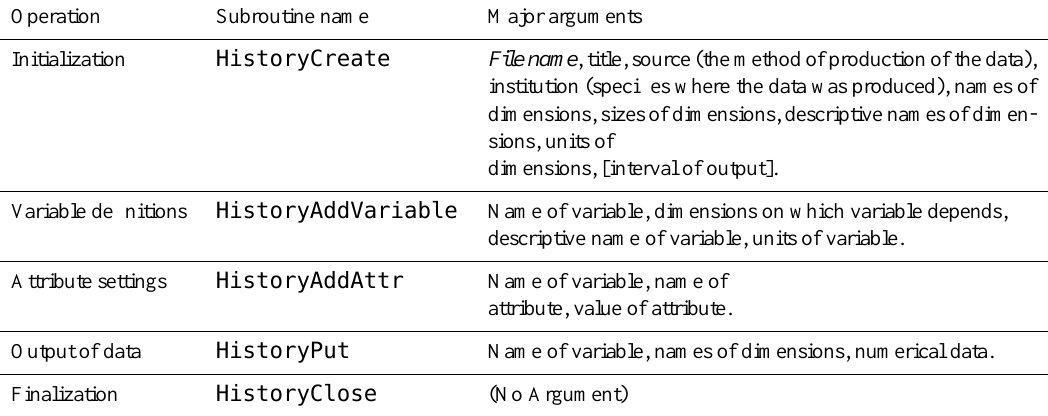
Table 1. Data input/output interface for small models in which multiple variables are output into a single file. Only major subroutines and some optional arguments (represented by parentheses) are shown. The item with an italic font does not exist in the interface shown in Table 2.